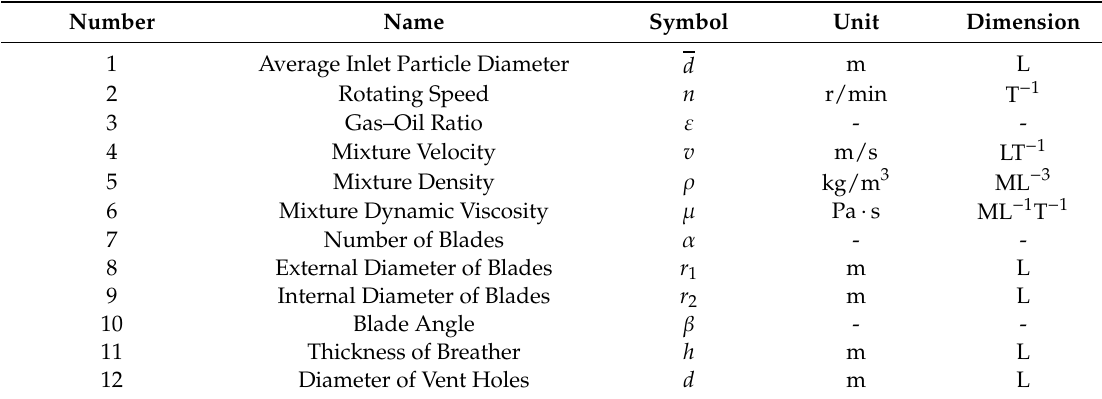
Table 4. Influencing factors and